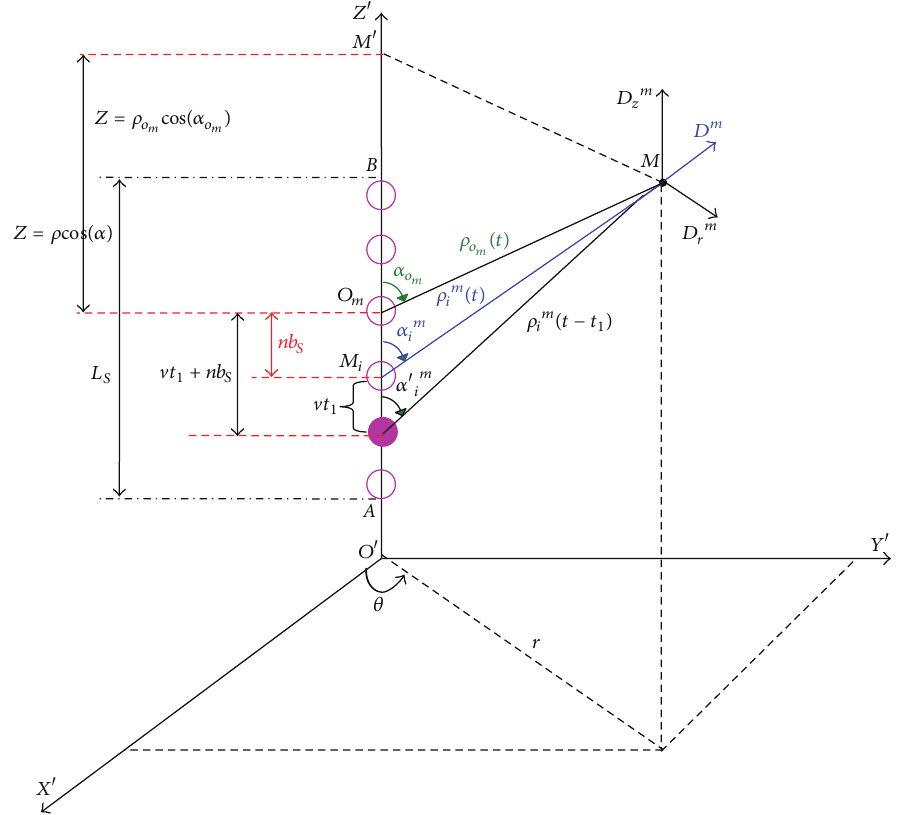
Figure 4: Representation of a moving polyion as a chain of successive charged